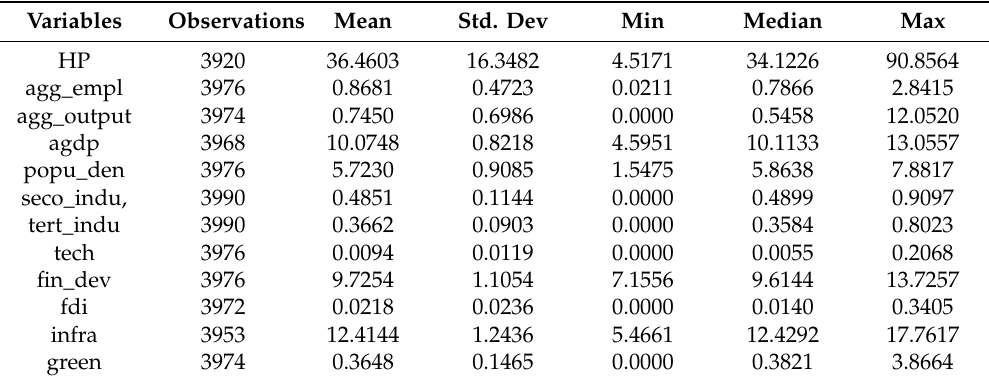
Table 1. Summary